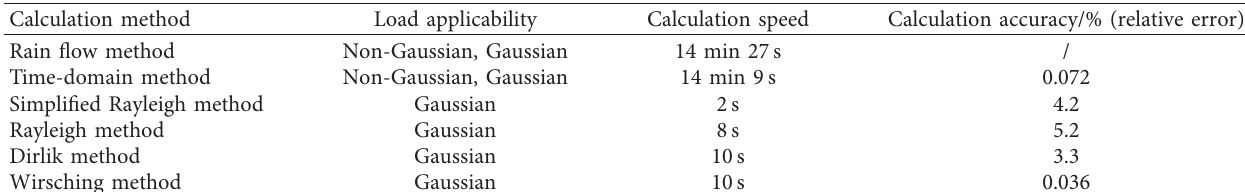
Table 1: Multi-dimensional comparison of the advantages and disadvantages of various FDS methods Calculation method